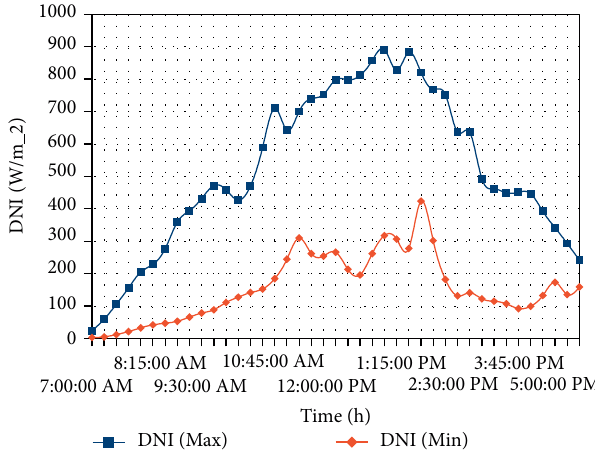
Figure 9: Temperature of air cycling through the storage and receiver heating from 7 AM to 5 PM for both higher and lower direct normal irradiance.